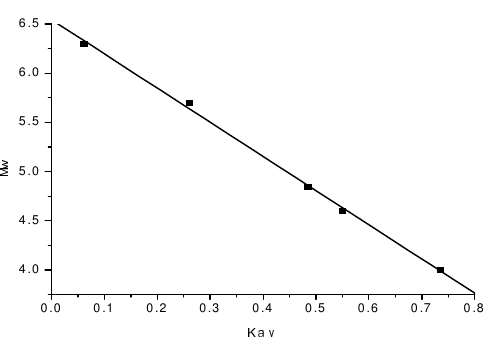
Figure 2. The standard curve of Mw and Kav.